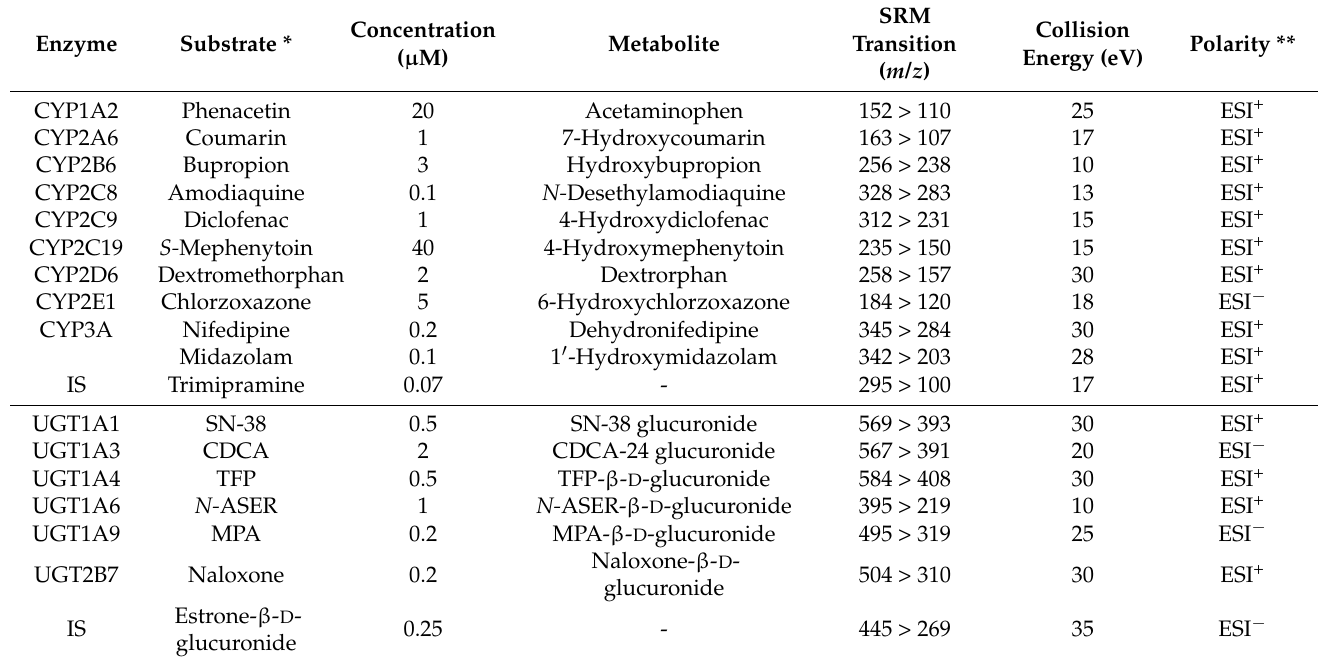
Table 1. Selected reaction monitoring (SRM) conditions for the major metabolites of the cytochrome P450 (P450) probe substrates and the uridine 5 (cid:48) -diphosphoglucuronosyl transferase (UGT) substrates used in all assays.